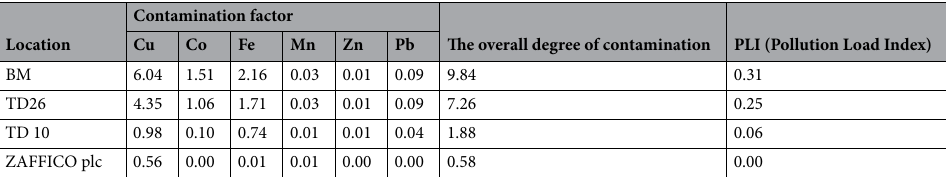
(Supplementary Table 2). The Co concentration at BM was above 13 ppm and above the global terrestrial average in soil, while Co concentration at TD26 and TD10 was below the global terrestrial average 44 . The soil obtained from BM had a higher Fe concentration compared with the soil from TD26 and TD10. The mean concentration of Fe in the soil from BM was 401.1 ppm (Supplementary Table 2). The mean concentration of Fe in soil from TD26 was 318.9 ppm (Supplementary Table 2) while the mean concentration of Fe in the soil from TD10 was lowest with 137.6 ± 102 ppm (Supplementary Table 2). However, the concentration of Fe was not significantly different among all tested tailing dams (Fig. 5). The mean Mn, Pb, Zn concentration in the soil from BM was 14.8 ppm, 2.3 ppm, and 1.05 respectively, whereas the mean concentration of Mn, Pb, and Zn in the soil from TD26 was 16.1 ppm, 2.3 ppm, and 0.9 ppm, respectively. At TD10, the mean concentrations were Mn (7.8 ppm), Pb (0.9 ppm), and Zn (0.6 ppm). In the baseline soil, the Mn concentration was 3.8 ppm, while the Pb and Zn were not detected. When compared gener- ally, the soil from Kitwe Tailing Dams (BM and TD26) had mean concentrations of each metal in a magnitude of 5–6 times more than to Mufulira Tailing Dam soil (TD10) (Fig. 5). To appreciate the correlation of heavy metal concentration between sites (BM, TD26, TD10), the Pearson’s correlation coefficients were applied based on sample points across all sites (Fig. 6). Cu, Co, Fe, and Pb concen- trations had a strong significant positive association with each other, suggesting a common origin. According to the scale of correlation coefficient (Supplementary Table 5), there were significant Mn-Cu, Fe-Cu, Fe-Co, Zn-Co, Zn-Cu, Pb-Cu, Pb-Co correlations indicating a common source and a close relation of the elements in the soil samples tested (Table 3).